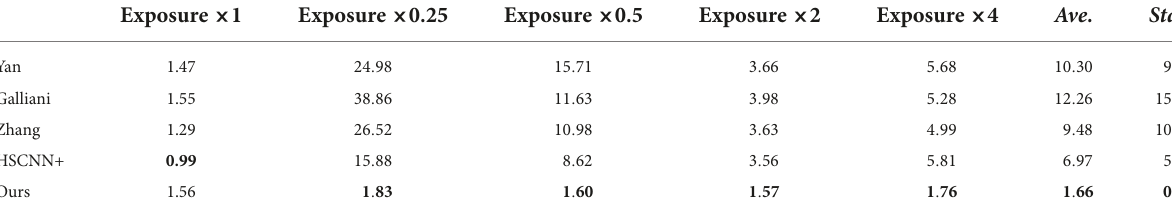
TABLE 3 Comparison of the spectral angle mapping (SAM) errors of different methods under different tested exposure levels. Exposure × 1 Exposure × 0.25 Exposure × 0.5 Exposure × 2 Exposure × 4 Ave. Std.